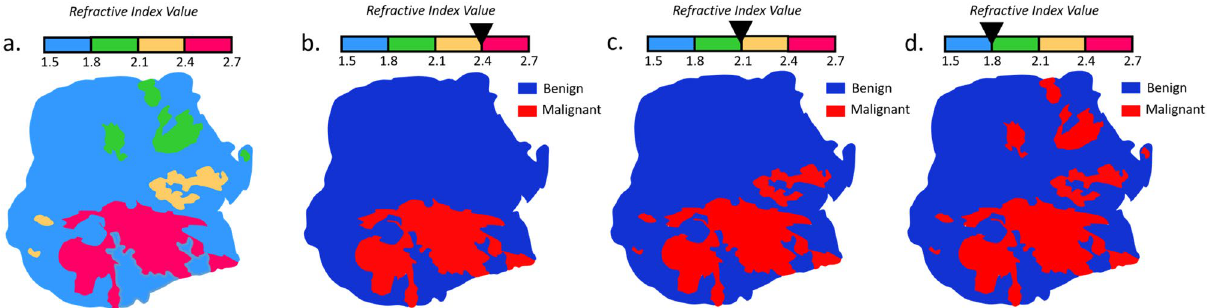
Figure 2. Thresholding principle applied to the refractive index map. ( a ) Schematic refractive index map; ( b ) binary refractive index map with a threshold set at 2.4; ( c ) binary refractive index map with a threshold set at 2.1; ( d ) binary refractive index map with a threshold set at